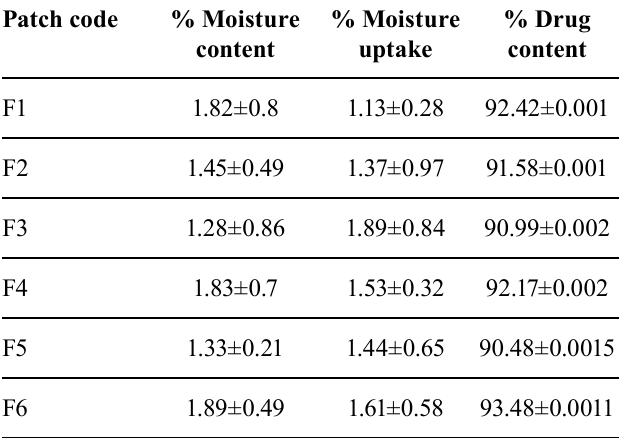
TABLE V – D ata of percentage moisture content, percentage moisture uptake and percentage drug content. ( n=3